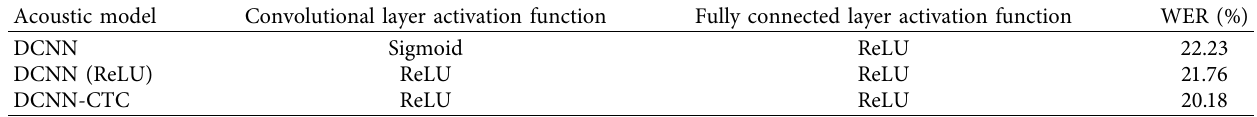
Table 3: Results of the network models on THCHS-30.